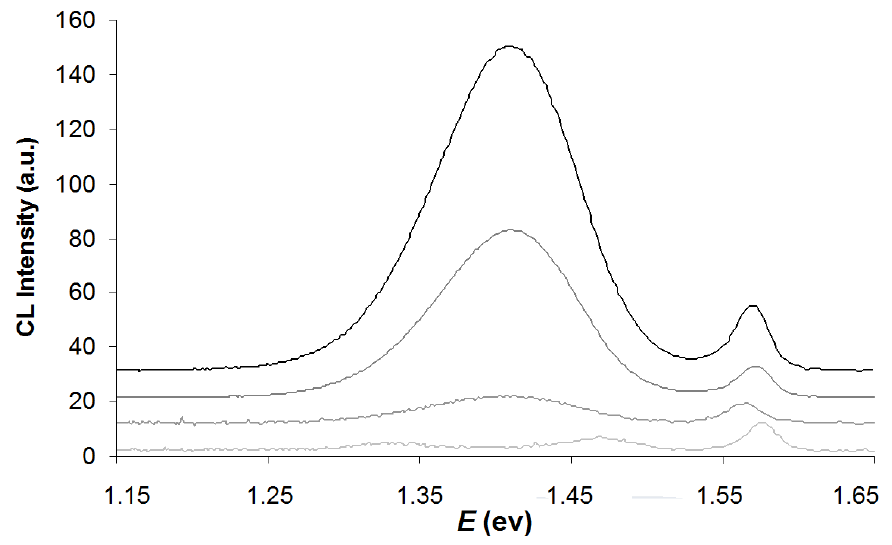
Figure 2. Comparison of CL spectra acquired for ( a ) un-treated CSS-CdTe and treated CSS-CdTe in 400 mbar Ar, and HCF Cl (Freon) atmosphere for 10 min using ( b ) 30 mbar, 2 ( c ) 40 mbar and ( d ) 50 mbar Freon partial pressure